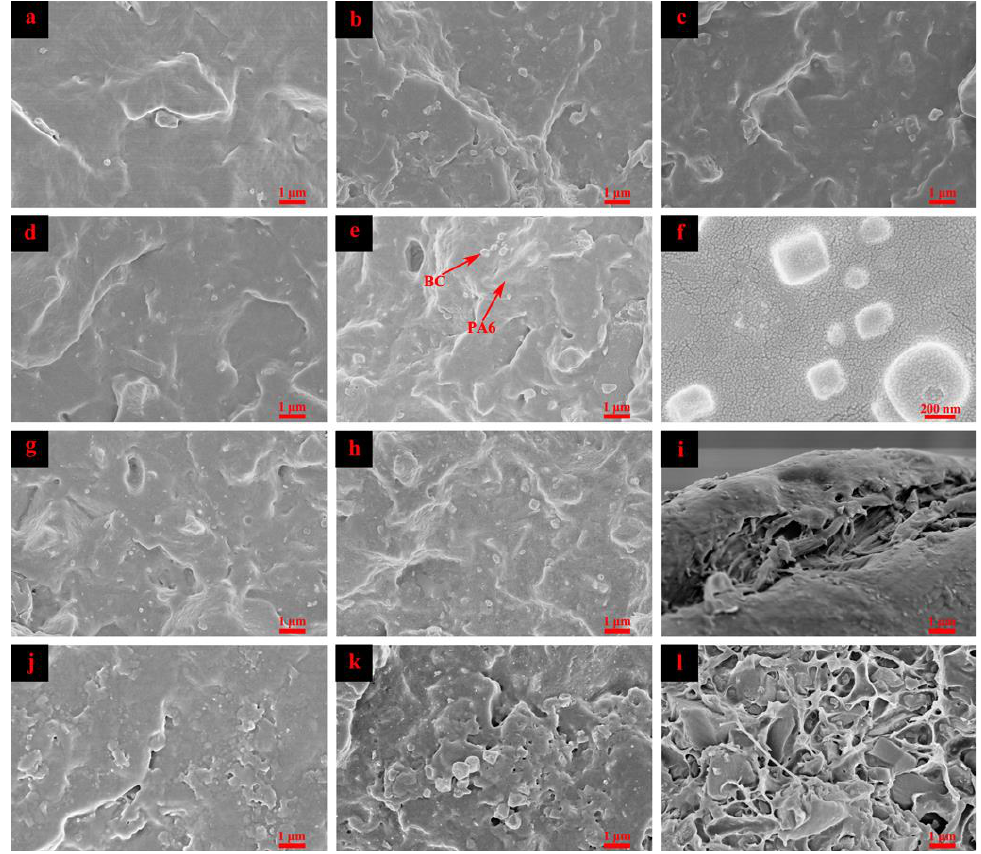
Figure 8. Scanning electron microscope (SEM) images of the impact section of PA6/BC composites with different BC contents, ( a , i ) PA6; ( b , j ) PA6/BC10; ( c ) PA6/BC20; ( d ) PA6/BC30; ( e , f , k ) PA6/BC40;